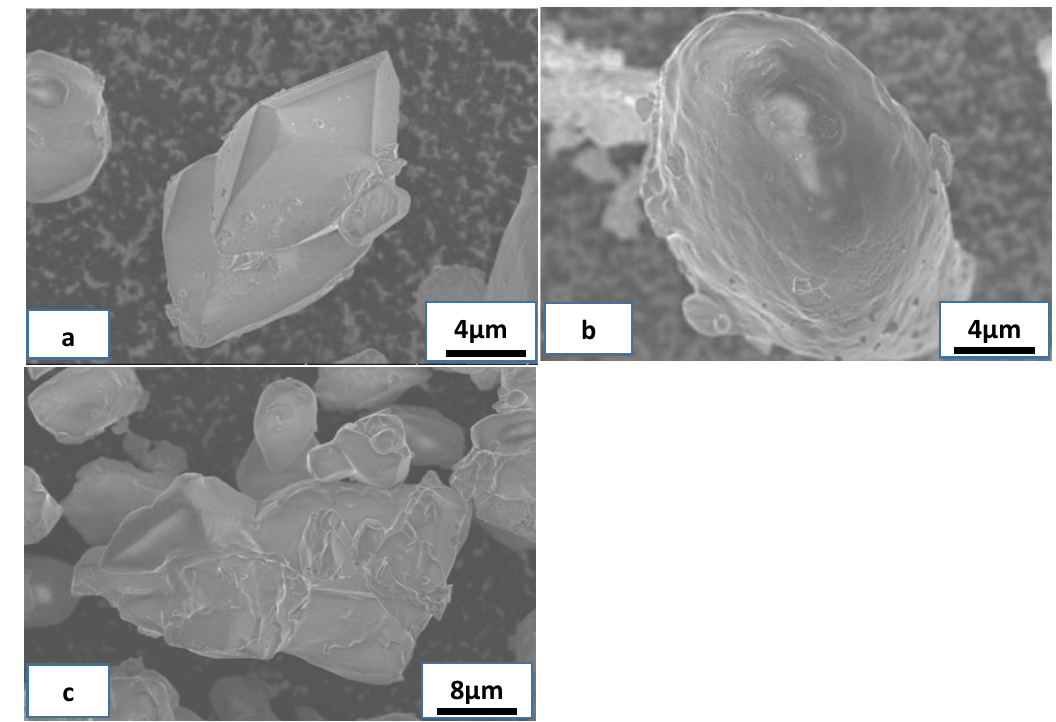
Figure 2. SEM images of NH 4 ReO 4 particles at different NH 3 wt %: ( a ) NH 3 10 wt %, ( b ) NH 3 15 wt %, ( c ) NH 3 20 wt %.